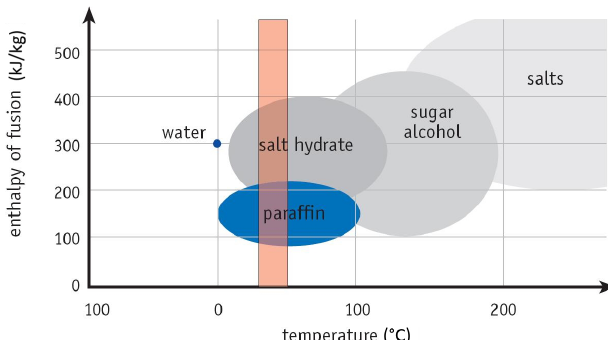
Figure 2. Classes of materials that can be used as phase change materials and their typical ranges of melting temperatures and melting enthalpies